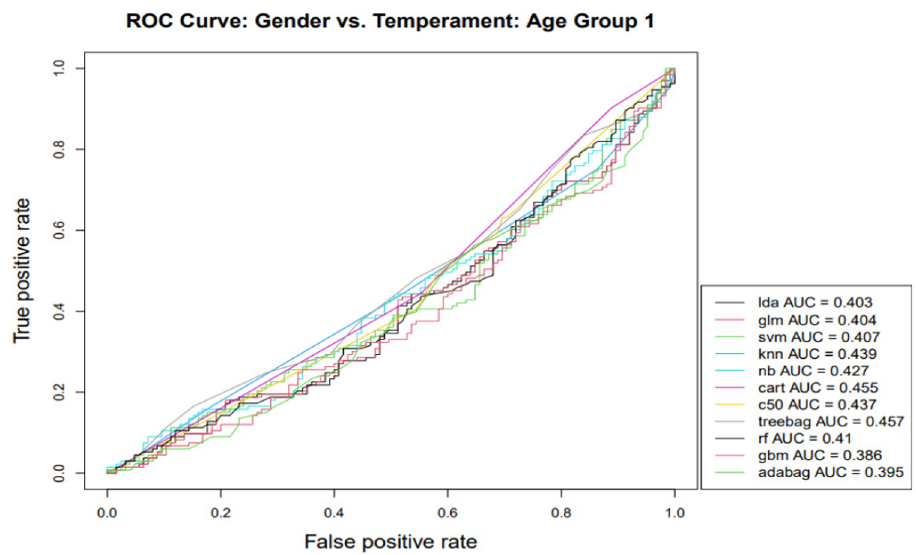
Fig 1. Note: lda—Linear Discriminant Analysis; glm—Generalized Linear Modeling; svm—Support Vector Machines; knn—K-Nearest Neighbor; nb—Na ï ve Bayes; cart—Classification and Regression Trees; c50—C5.0 Classification; treebag—Bootstrapped Aggregated Trees; rf—Ensembled Decision Trees (Random Forest); gbm— Gradient Boosting Method; adabag—Multi-class Adaptive Boosting (AdaBoost).